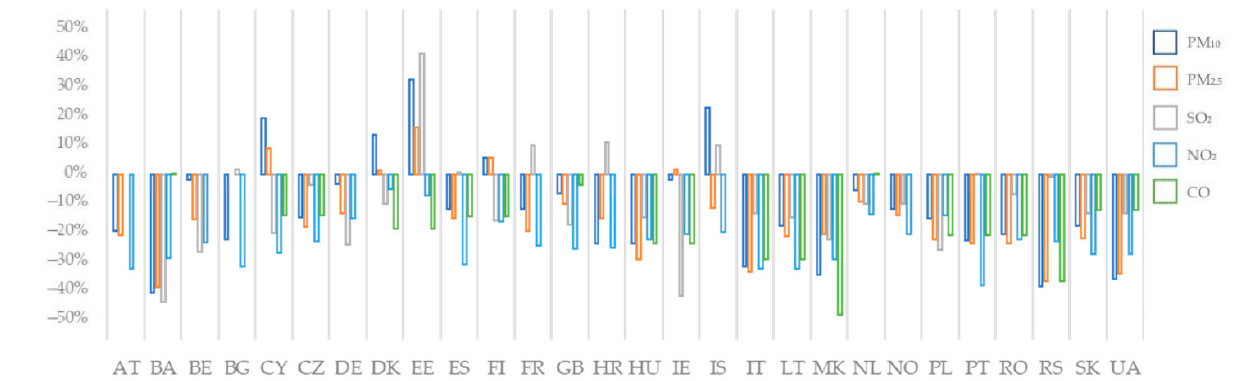
Figure 5. Changes in pollutants concentration in urban air at the surface level.